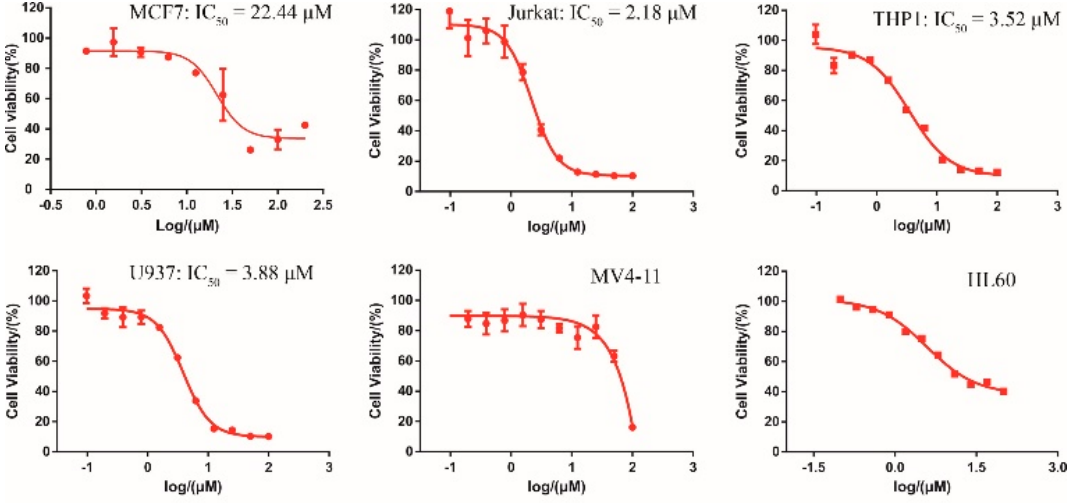
Figure 4. Cellular activity of DC-S285 against different cell lines.